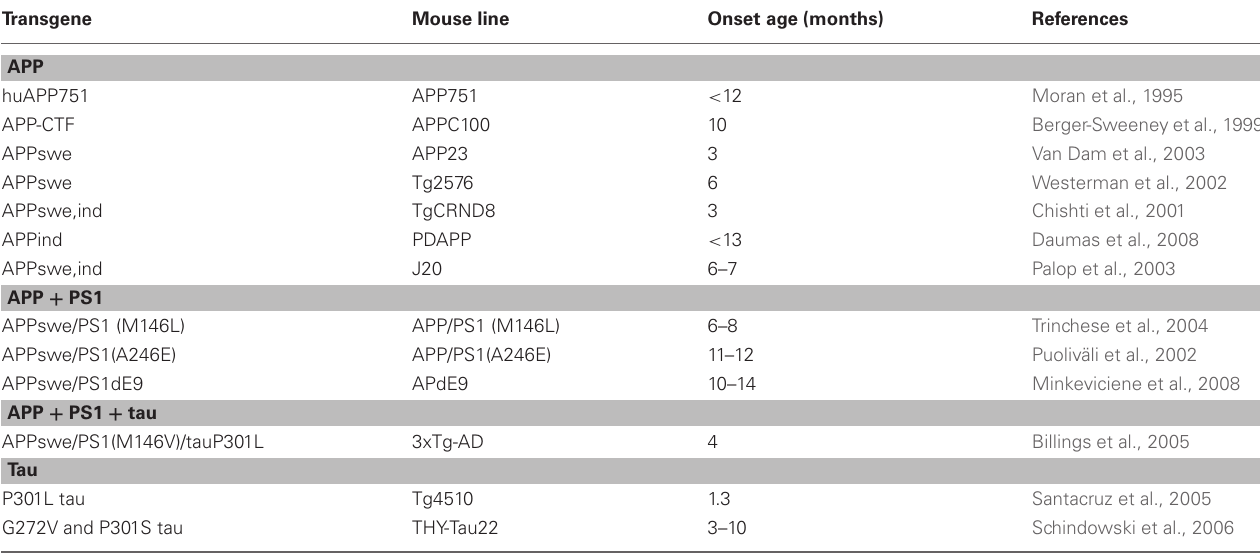
Table 1 | Summary of genetic mouse models of Alzheimer’s disease with reported impairment in the Morris swim navigation task. Transgene Mouse